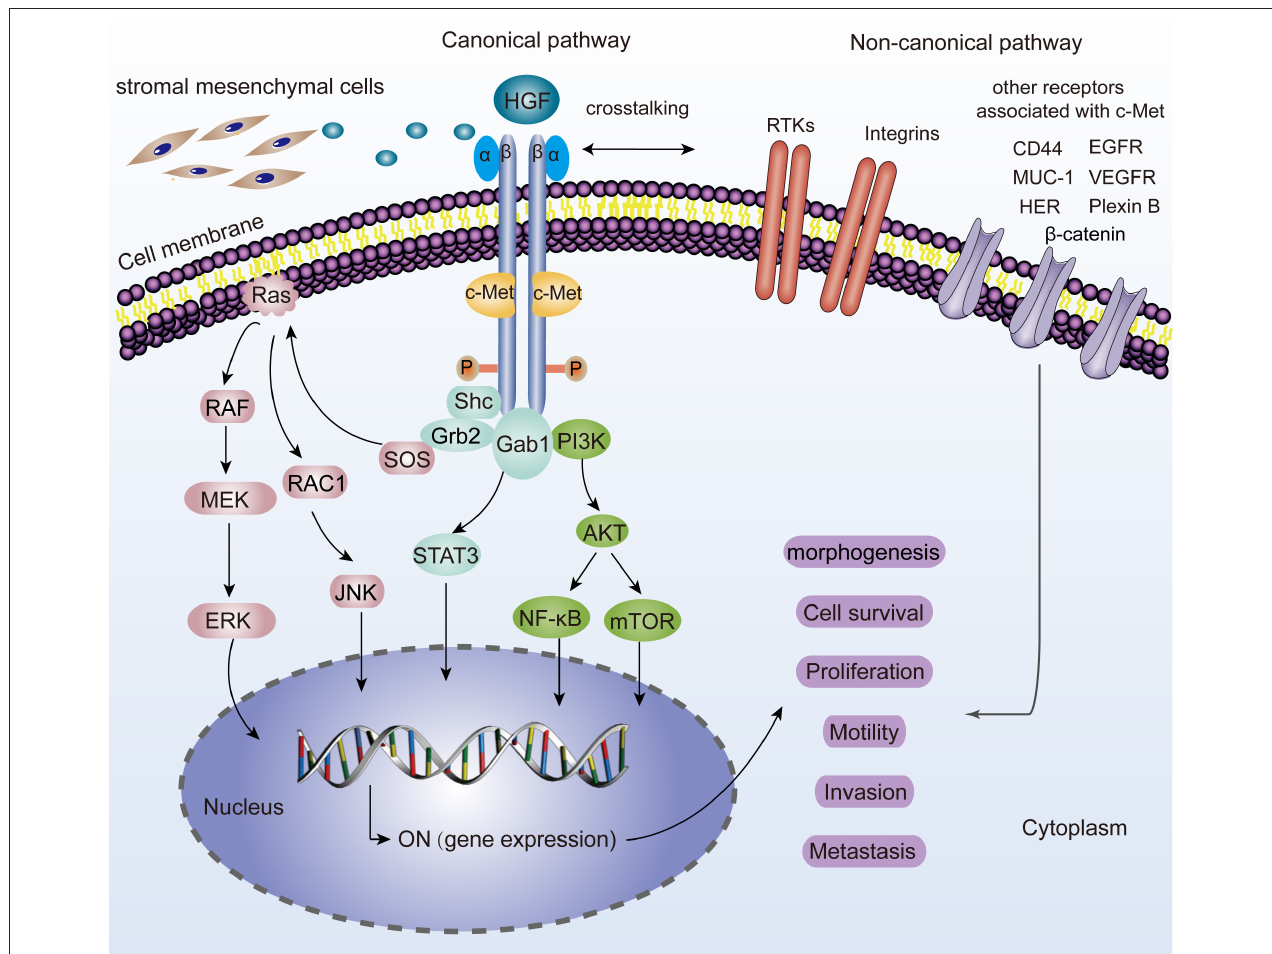
FIGURE 1 | Representation of the HGF/c-Met canonical and non-canonical pathways. For canonical pathways, the binding of HGF, induces two c-Met molecules dimerization, thereby leading to the autophosphorylation of tyrosine residues and subsequent activation of many downstream signaling pathways such as MAPK/ERK, STAT3, PI3K/AKT signaling. JNK is also phosphorylated and activates a variety of downstream substrates, including transcription factors such as AP-1 and apoptosis-related Bcl-2, Bax, etc. All these hereby basically drive a plethora of cell phenotypes such as morphogenesis, survival, proliferation, motility, invasion, and metastasis. “ON” means the activation for gene expression. Non-canonical pathways are activated when c-Met binds to other receptors including EGFR, MUC-1, VEGFR, CD44, Plexin B1, HER, Integrin α 6 β 4, β -catenin, and so